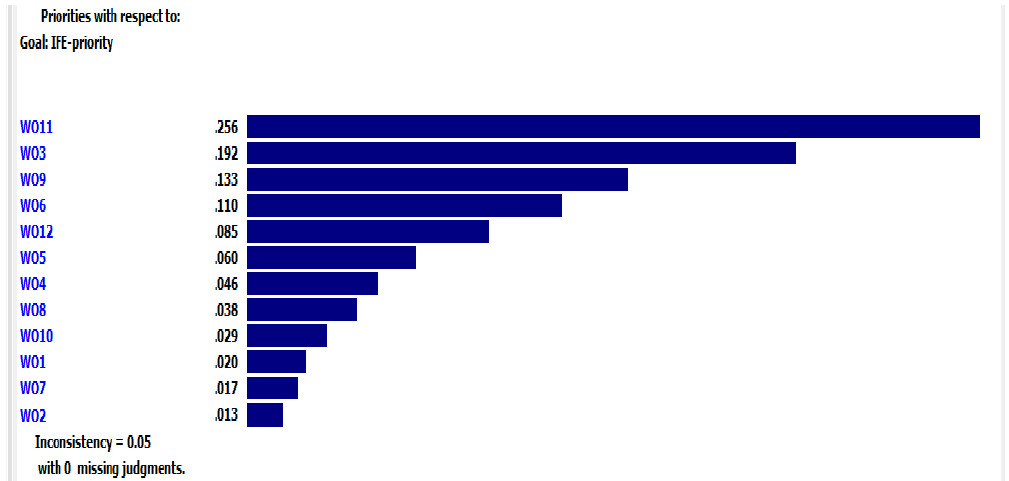
Fig. 7: WO strategies prioritization by AHP and EC for Farahzad River Valley